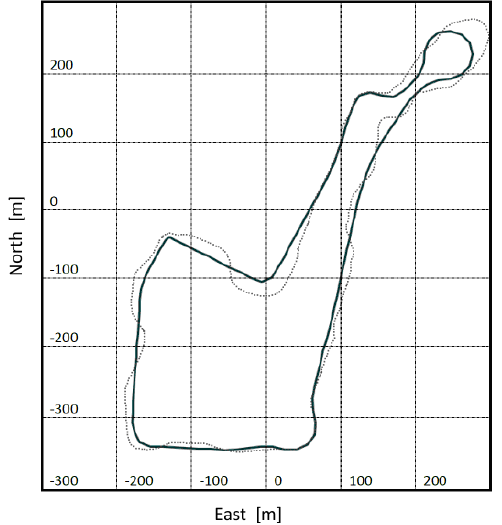
Figure 10. The estimated trajectory (dotted line) overimposed onto the GPS reference track (solid line).